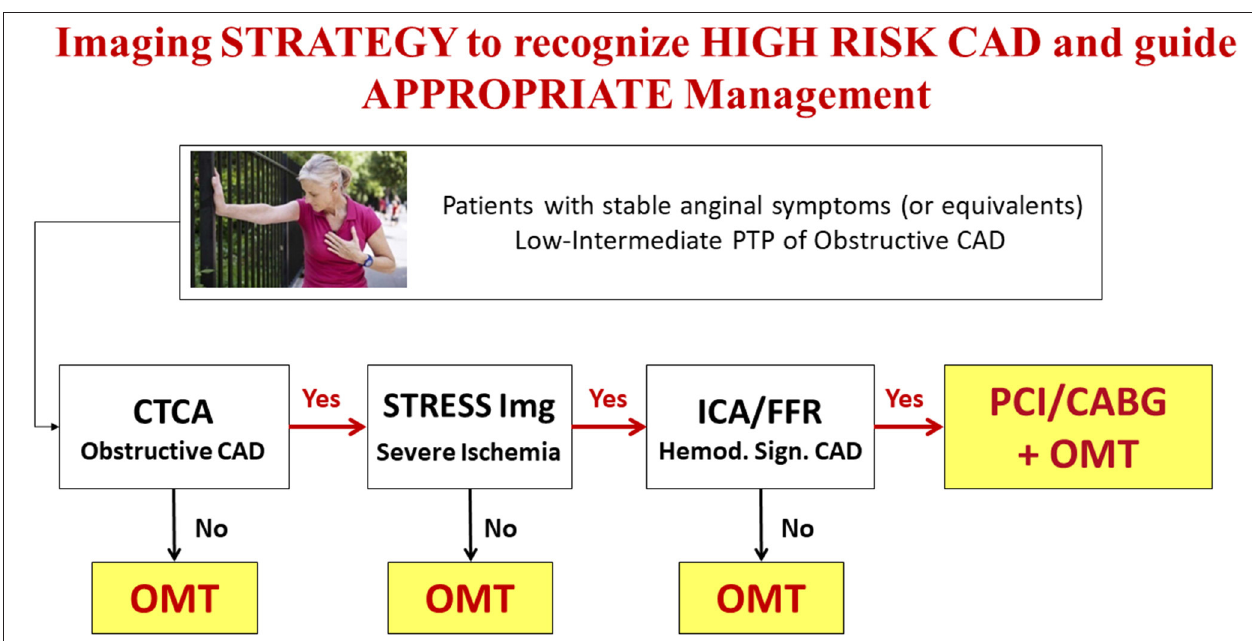
FIGURE 1 | Anatomical and functional imaging integrated strategy to recognize “High Risk” CAD and guide management in patients with low-intermediate PTP of obstructive CAD (see text for details). OMT, Optimal Medical